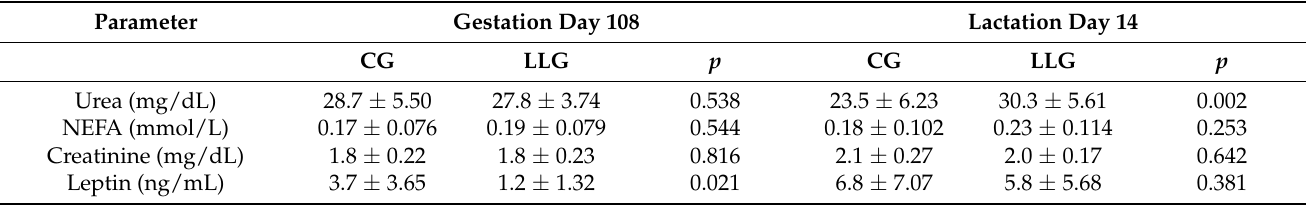
Table 6. Blood parameters (mean ± standard deviation) on day 108 of gestation and on day 14 of lactation ( n = 15 per